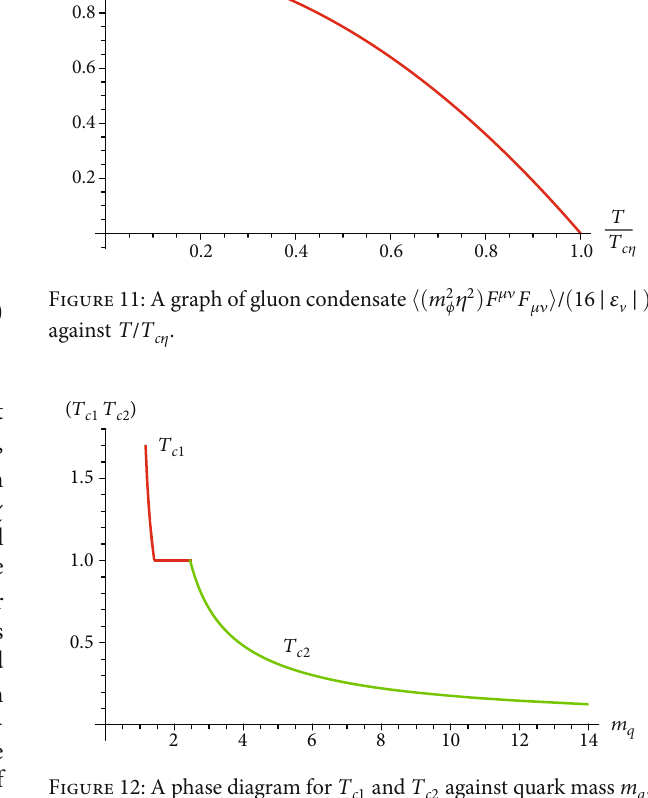
and T against quark mass m c 1 c 2